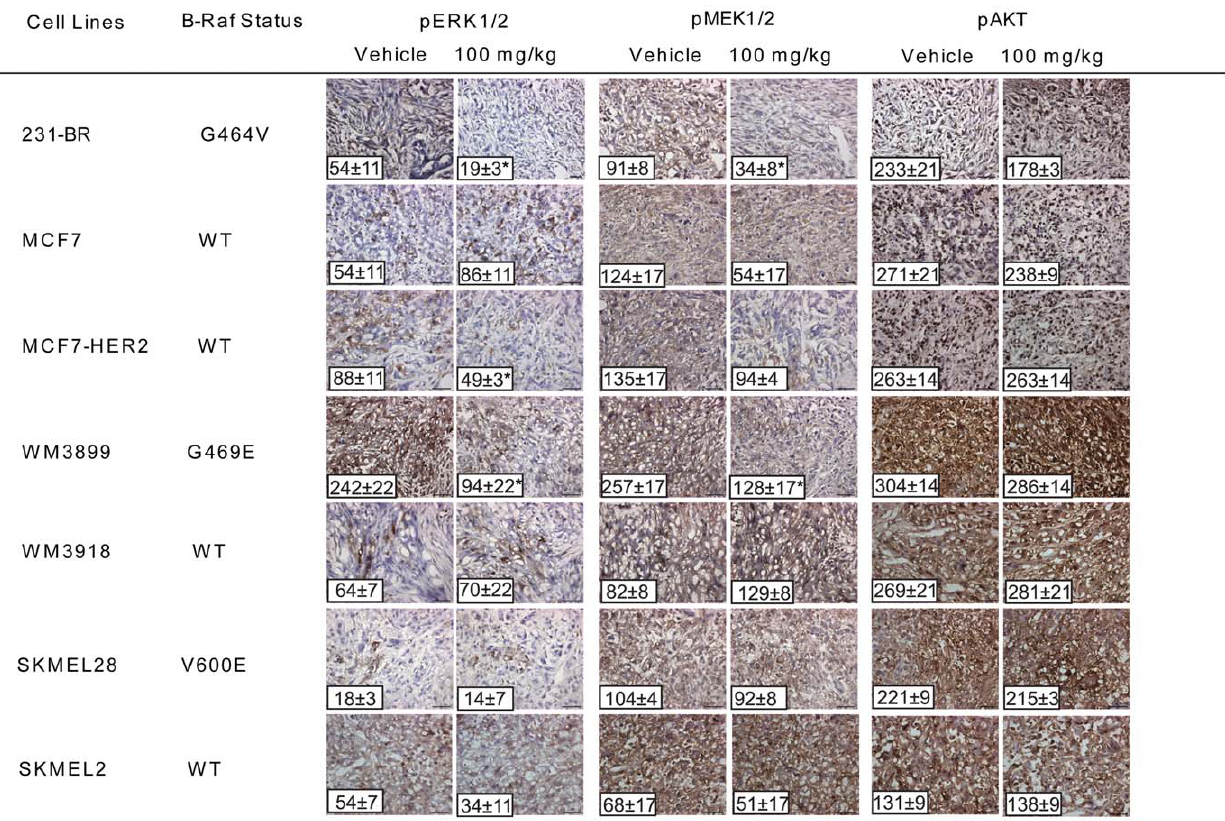
Figure 3. Pazopanib inhibition of primary tumor growth correlates with B-Raf inhibition. Tumor cell lines and the B-Raf genotypes are listed. Representative photographs of pERK1/2, pMEK1/2 and pAKT immunostaining are shown for the vehicle and the 100 mg/kg pazopanib treated groups. The mean number of positive cells 6 SEM is shown on each representative image. Asterisks (*) indicate a statistically significant difference between the pazopanib and vehicle treated group (p , 0.01). (See Figure S3 for the 30 mg/kg dose data).